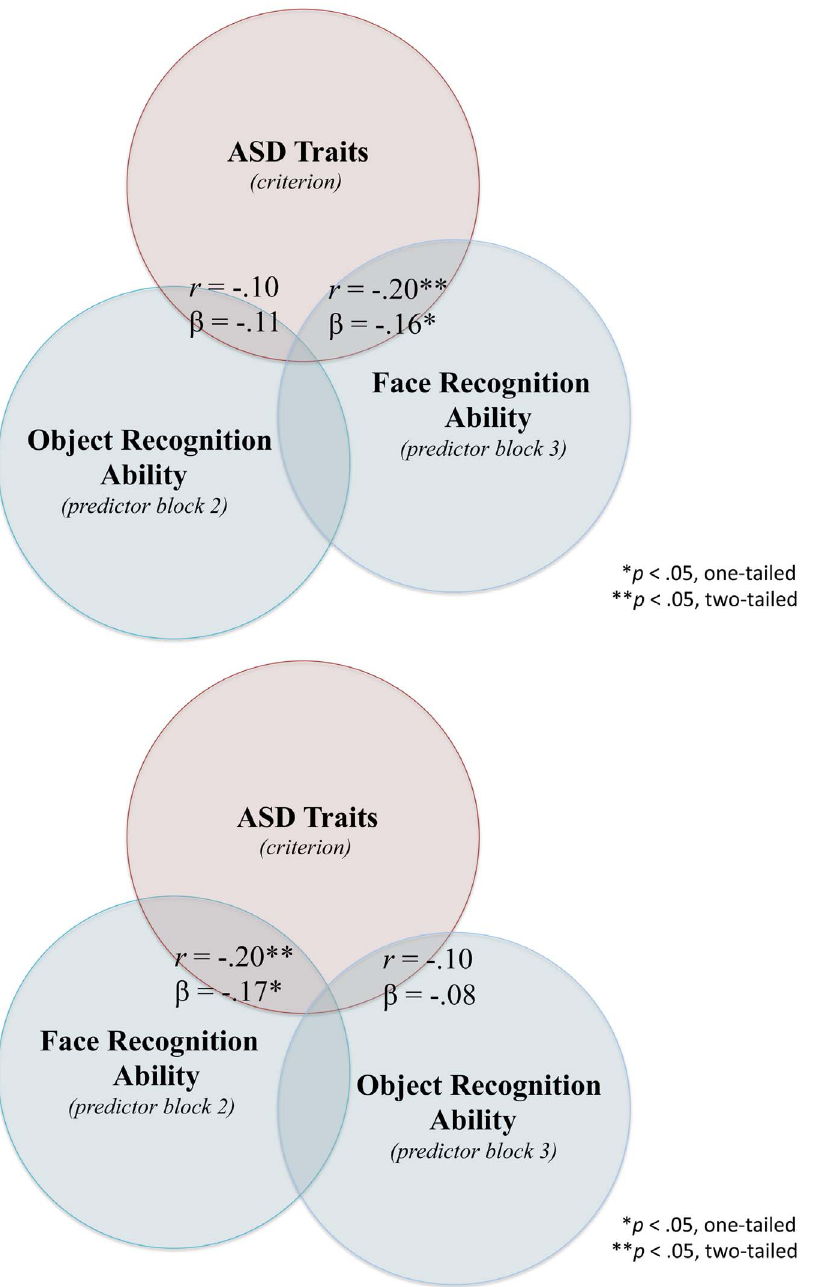
Figure 3. Venn representation of hierarchical regression analysis with Autism Quotient scores as the criterion variable showing shared and unique variance with predictor variables. The variables presented are ‘‘selective’’ (i.e., gender and major are omitted from the diagram), however their effects are controlled for in the betas reported. ( a ) Selected predictor variables include stage 2 face recognition (IM Face) and stage 3 object recognition (IM Bird) or ( b ) stage 2 object recognition (IM Bird) and stage 3 face recognition (IM Face); b values reported at the stage the variable was entered. The overlap between predictors is not represented to scale and is for illustrative purposes.